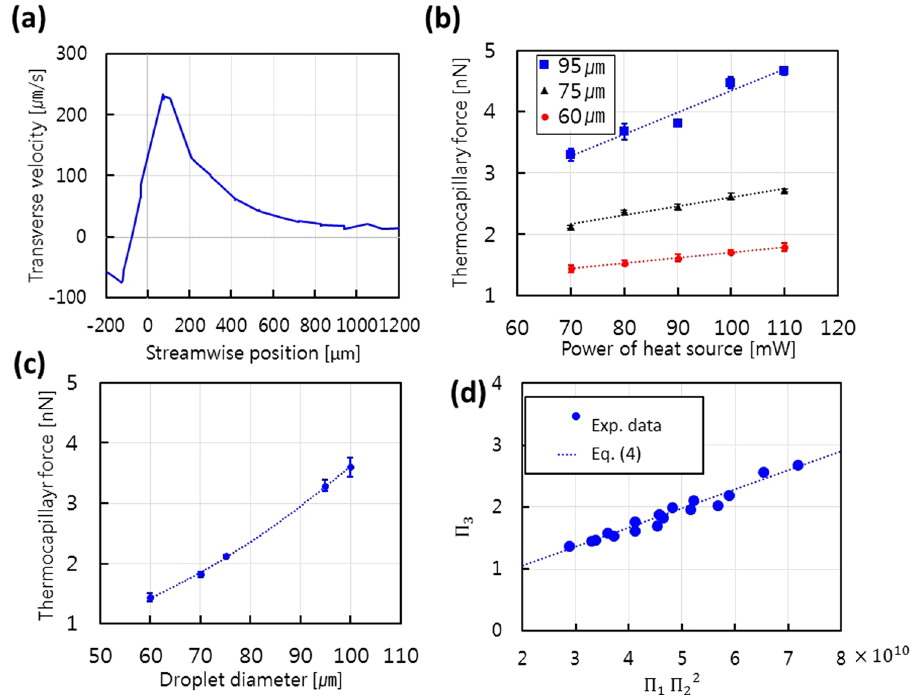
Figure 2. The thermocapillary force estimation and its empirical relations. ( a ) The transverse velocity of a droplet with a diameter of 60 μ m and a streamwise velocity of 1.16 mm/s. The velocity was estimated via images successively captured at 30 fps. The transverse velocity reached its maximum at a point about 100 μ m downstream from the laser beam center. The effects of ( b ) power of the heat source (linear fitting, R 2 = 0.9606) and ( c ) droplet diameter (square fitting, R 2 = 0.9993) on thermocapillary force. Each point was obtained by repeating the experiment 10 times. ( d ) The non-dimensional relationships of thermocapillary force ( Π 3 ) to power of the heat source ( Π 1 ) and droplet diameter ( Π 2 ). The dotted lines represent Equation (4) with coefficients A 1 and A 2 equal to 3.088 × 10 − 11 and 0.432, respectively. The R 2 value is